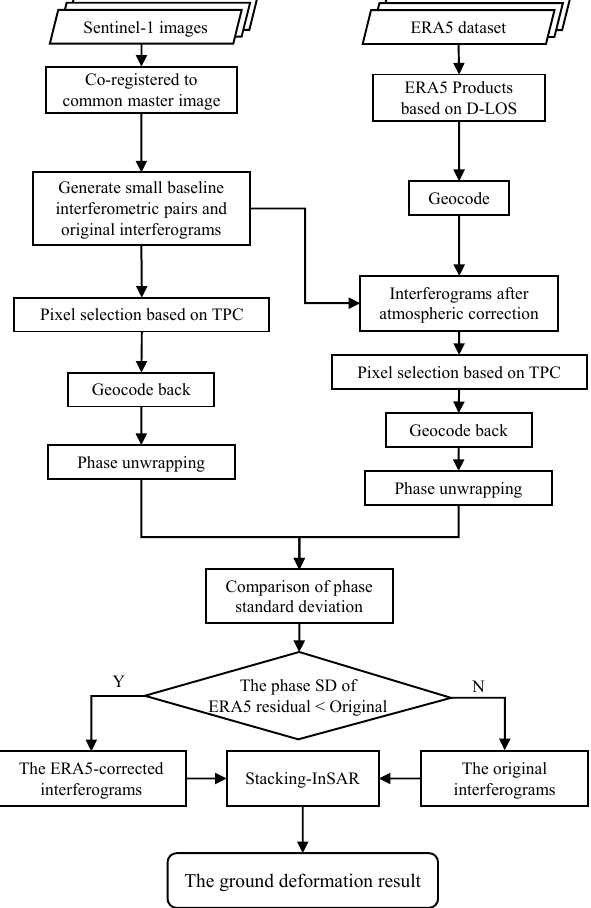
Figure 3. Data processing flowchart of adaptive ERA5-Corrected